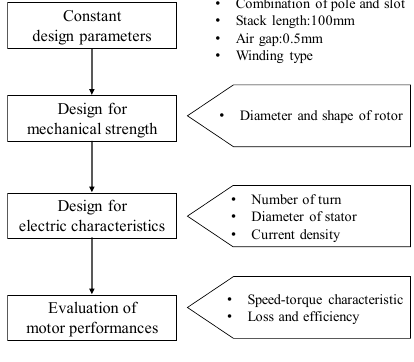
Figure 2. Design flow.